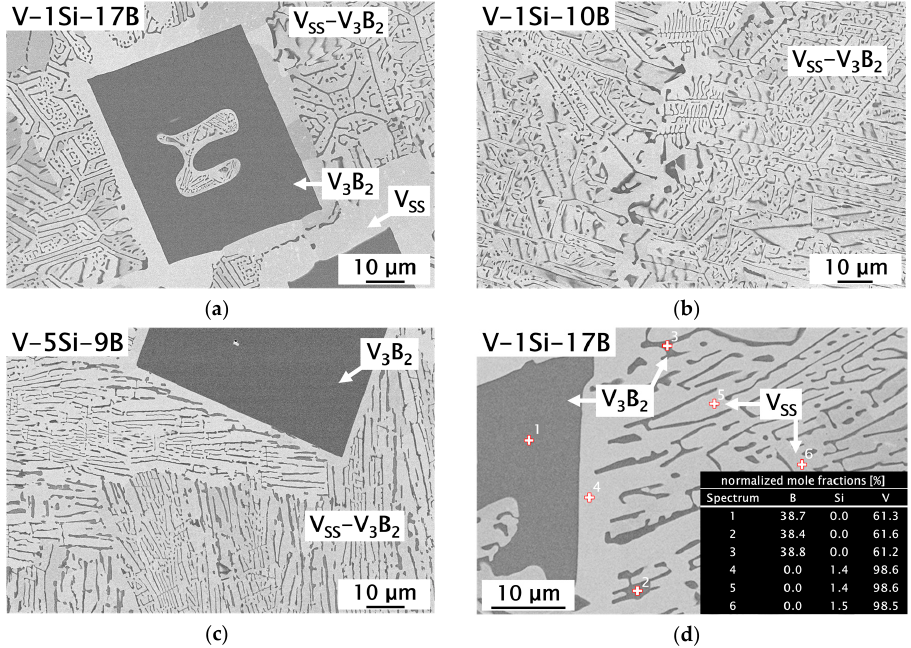
Figure 5. SEM ‐ BSE images showing the as ‐ cast microstructure (in part with small V SS halos around Figure 5. SEM-BSE images showing the as-cast microstructure (in part with small V SS halos around the the primary V 3 B 2 ) of the ternary V ‐ Si ‐ B alloys: ( a ) V ‐ 1Si ‐ 17B; ( b ) V ‐ 1Si ‐ 10B; ( c ) V ‐ 5Si ‐ 9B and ( d ) results primary V 3 B 2 ) of the ternary V-Si-B alloys: ( a ) V-1Si-17B; ( b ) V-1Si-10B; ( c ) V-5Si-9B and ( d ) results of of EDS spot analyses for V ‐ 1Si ‐ 17B. EDS spot analyses for